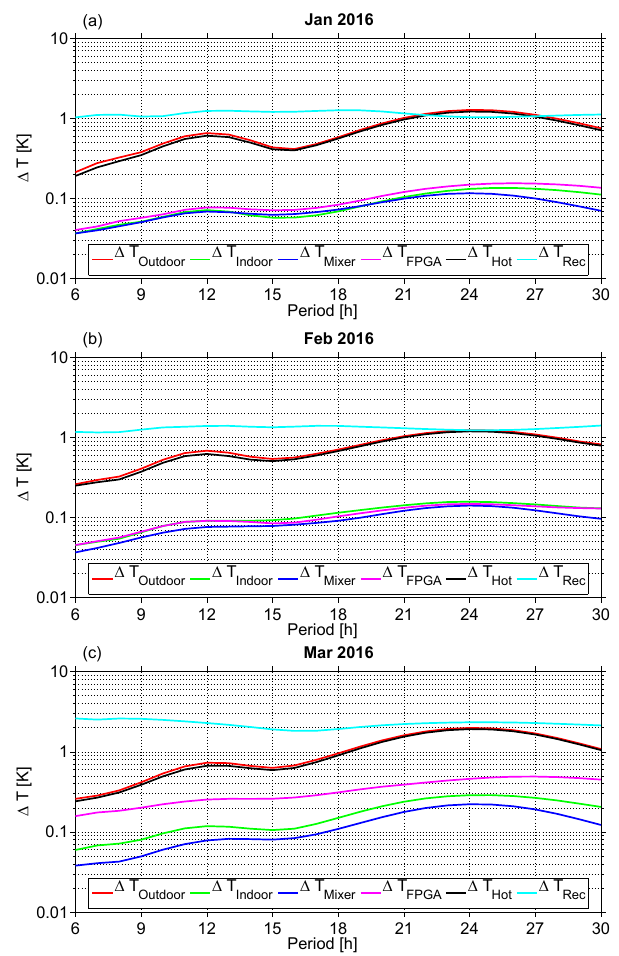
Figure 10. Monthly mean spectral wave analysis for six different temperature parameters related to the MIAWARA water vapor ra- diometer: outdoor, indoor, mixer, FPGA, hot-load and receiver tem- perature. Spectral analysis goes from 6 to 30h with a resolution of 1h. The results are shown for January, February and March